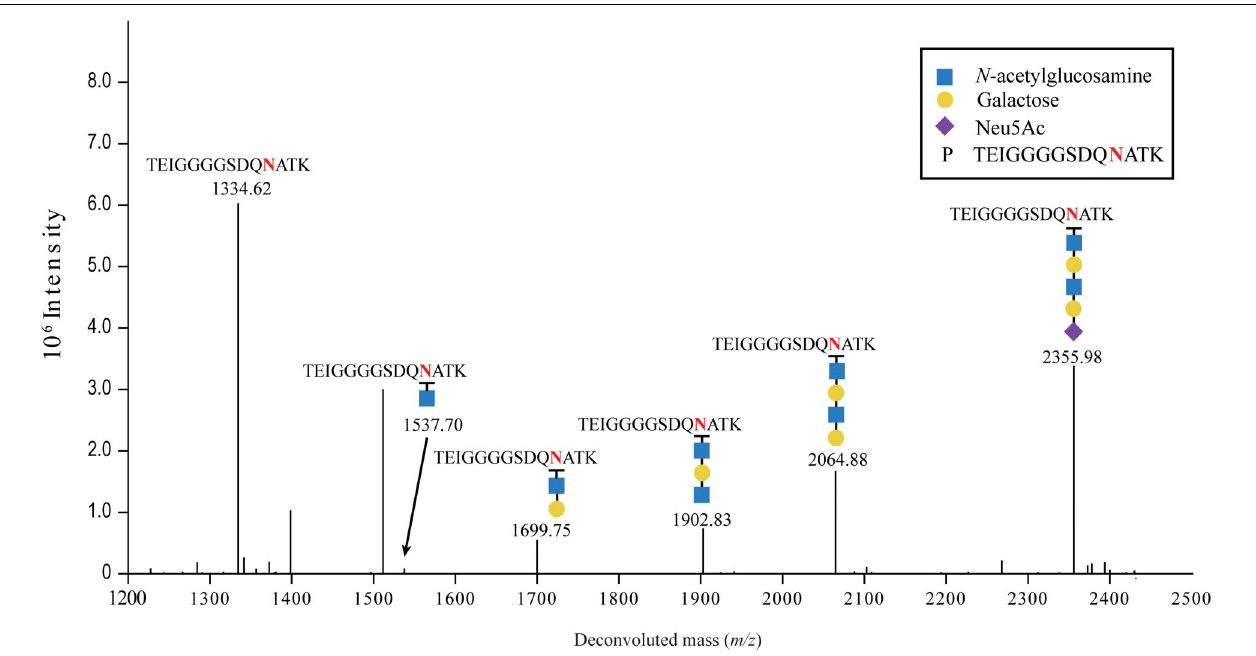
FIGURE 3 | LC-MS/MS analysis of sialylated glycoproteins. Purified FN3 carrying the sialylated glycan was analyzed by LC-MS/MS after enzymatic digestion. The fragmentation spectrum of the Neu5Ac- α -2,6-Gal- β -1,4-GlcNAc β -1,3-Gal- β -1,3-GlcNAc-TEIGGGGSDQNATK glycopeptide is shown. The peaks at m/z 1334.62 and 2355.98 correspond to the TEIGGGGSDQNATK peptide and the sialylated TEIGGGGSDQNATK glycopeptide containing a NeuAc(1)Hex(2)HexNAc(2) glycan, respectively. Peaks at m/z , and 2064.88, 1902.83, 1699.75, and 1537.70 correspond to loss of, NeuAc(1), NeuAc(1)Hex, NeuAc(1)Hex(1)HexNAc(1), and NeuAc(1)Hex(2)HexNAc(1), respectively, from the sialylated glycopeptide. Blue squares, yellow circles and purple diamonds indicate GlcNAc, Gal, and Neu5Ac residues, respectively.